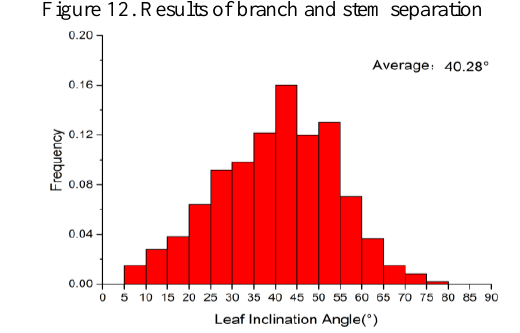
Figure 12. Results of branch and stem separation